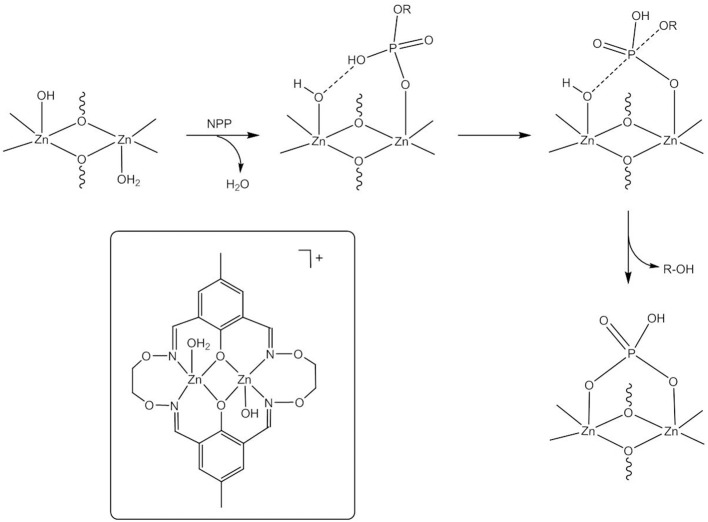
Catalytic species and proposed mechanism for NPP− hydrolysis by the dizinc(II) complex of H2L1a.